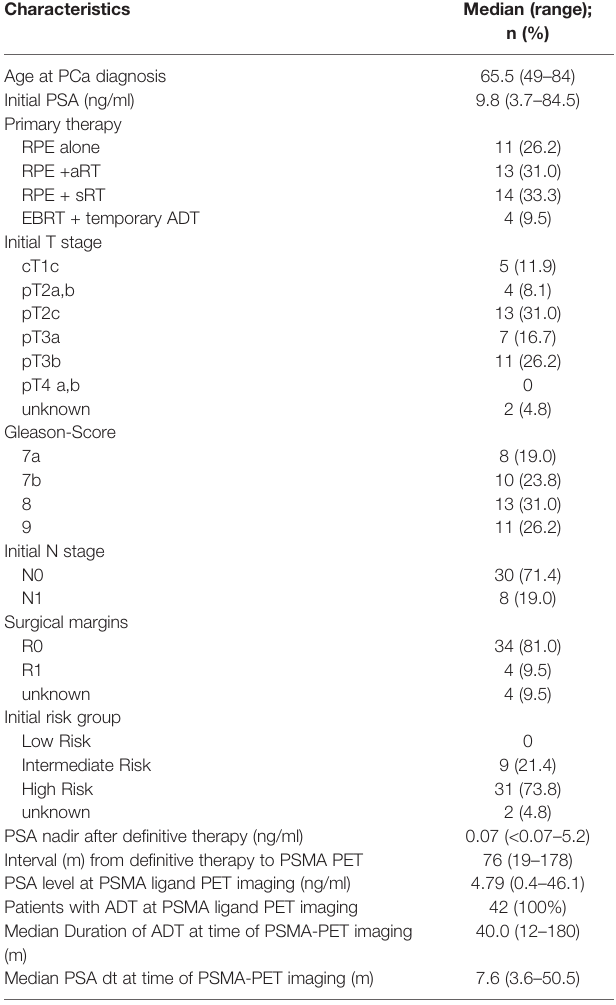
TABLE 1 | Patient characteristics (n =